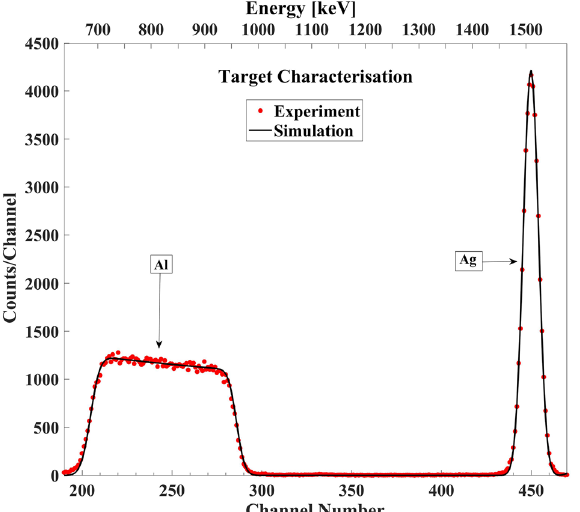
Figure 1. Typical simulated and measured RBS spectra from a thin Al/Ag target obtained at scattering angle 150° and E α = 1.8